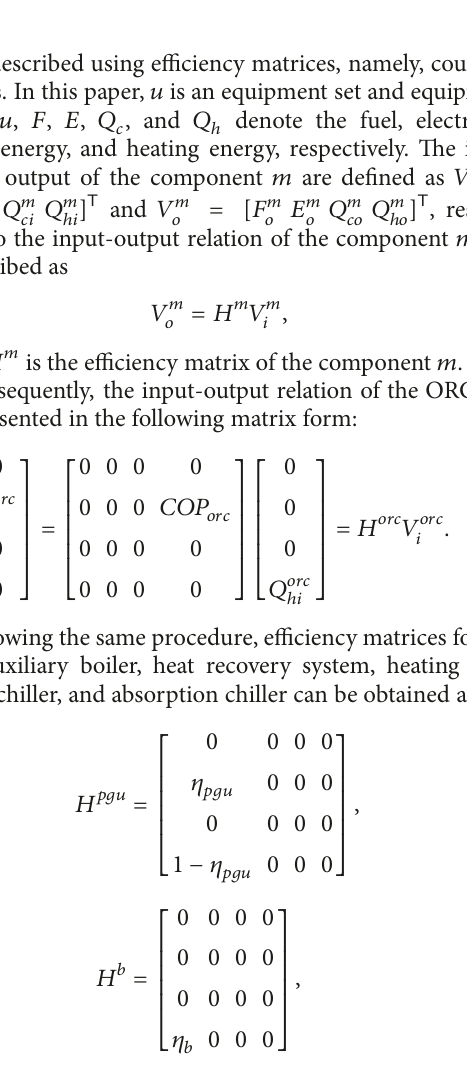
Figure 1: Structure diagram of a CCHP-ORC